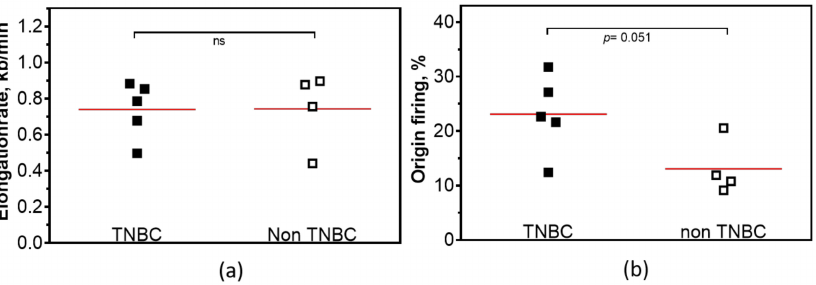
Figure 2. Replication stress in TNBC compared to non-TNBC. ( a ) Replication fork progression and ( b ) activation of replication origins in untreated cell lines of TNBC in comparison to untreated non-TNBC breast cancer cell lines. (Student’s t -test p = 0.98 ( a ) and p = 0.051 ( b ). Each value represents the mean of three independent